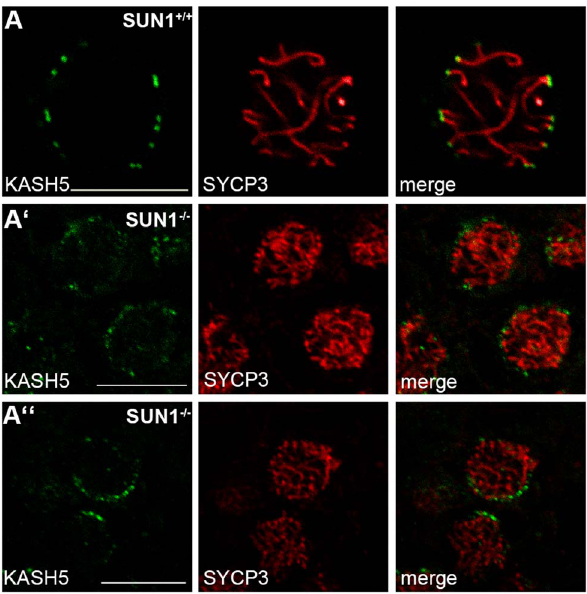
Figure 2. KASH5 localization in SUN1 deficient males. Repre- sentative spermatocytes in paraffin sections of Sun1 + / + ( D ex10-11) and Sun1 2 / 2 ( D ex10-11) testis stained for SYCP3 and KASH5. In the wildtype (A) the expected KASH5 localization at the distal ends of synaptonemal complex axes can clearly be observed. In Sun1 2 / 2 ( D ex10-11) spermato- cytes (A 9 –A 0 ) the KASH5 signal, although weaker, is also clearly detectable. As seen in the wildtype, distinct KASH5 foci also co-localize with the ends of synaptonemal complex axes. Scale bars 10 m m.